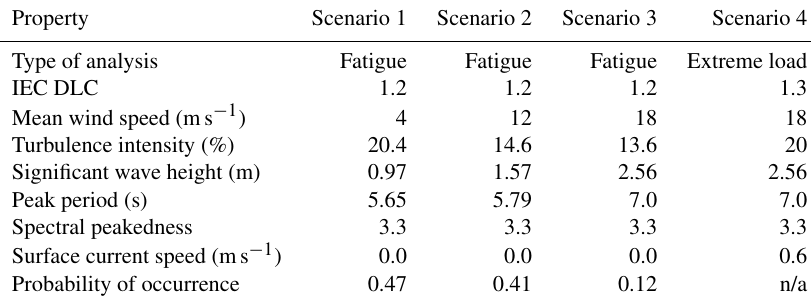
Table 2. Properties of the loading scenarios. International Electrotechnical Commission (IEC) design load cases (DLCs) refer to International Electrotechnical Commission